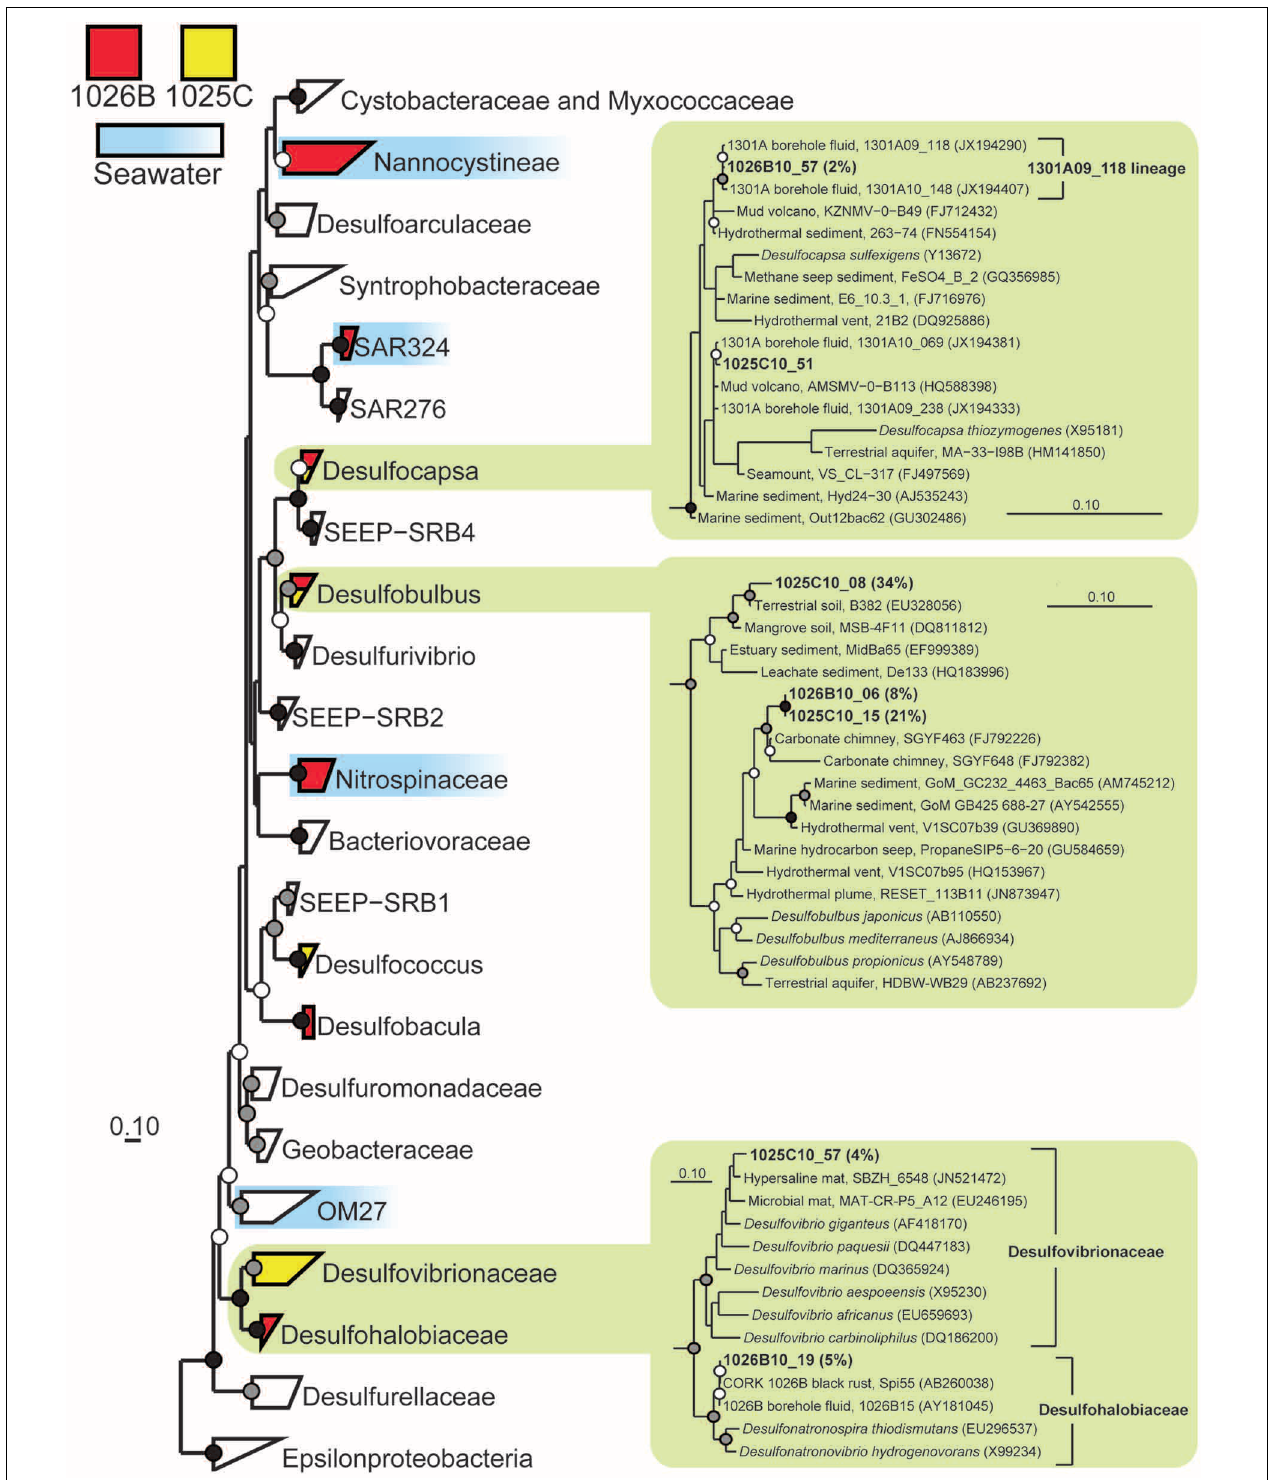
FIGURE 3 | Phylogenetic relationships of SSU rRNA gene clones related to the phylum Deltaproteobacteria , colored according to borehole of origin. Clones derived from nearby bottom seawater are shown in blue (Jungbluth et al., 2013). Cultivated Epsilonproteobacteria were used as an outgroup (not shown). Detailed phylogenies are shown for selected lineages.